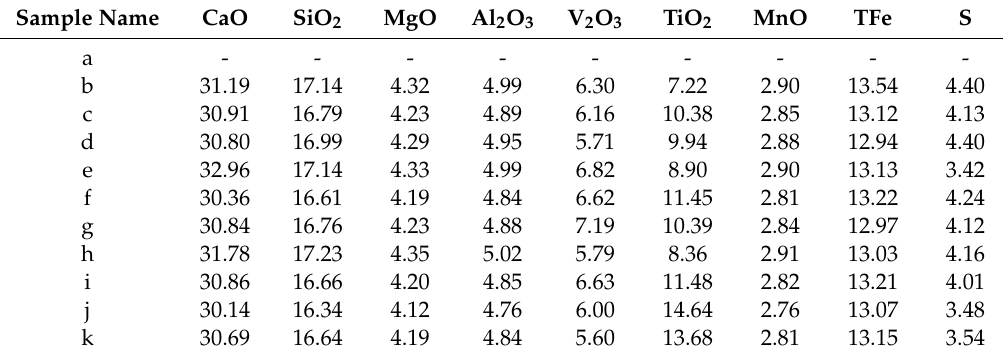
Table 5. Compositions of slag after desulfurization (wt.